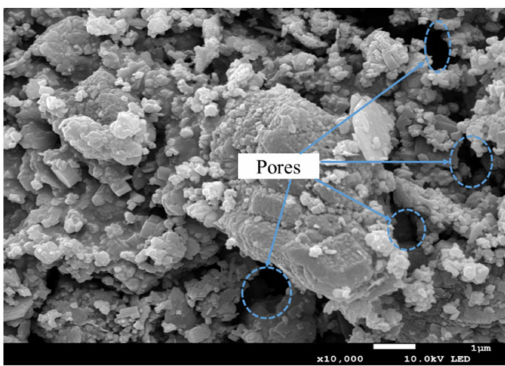
Figure 4. SEM micrograph of CPB with red mud.